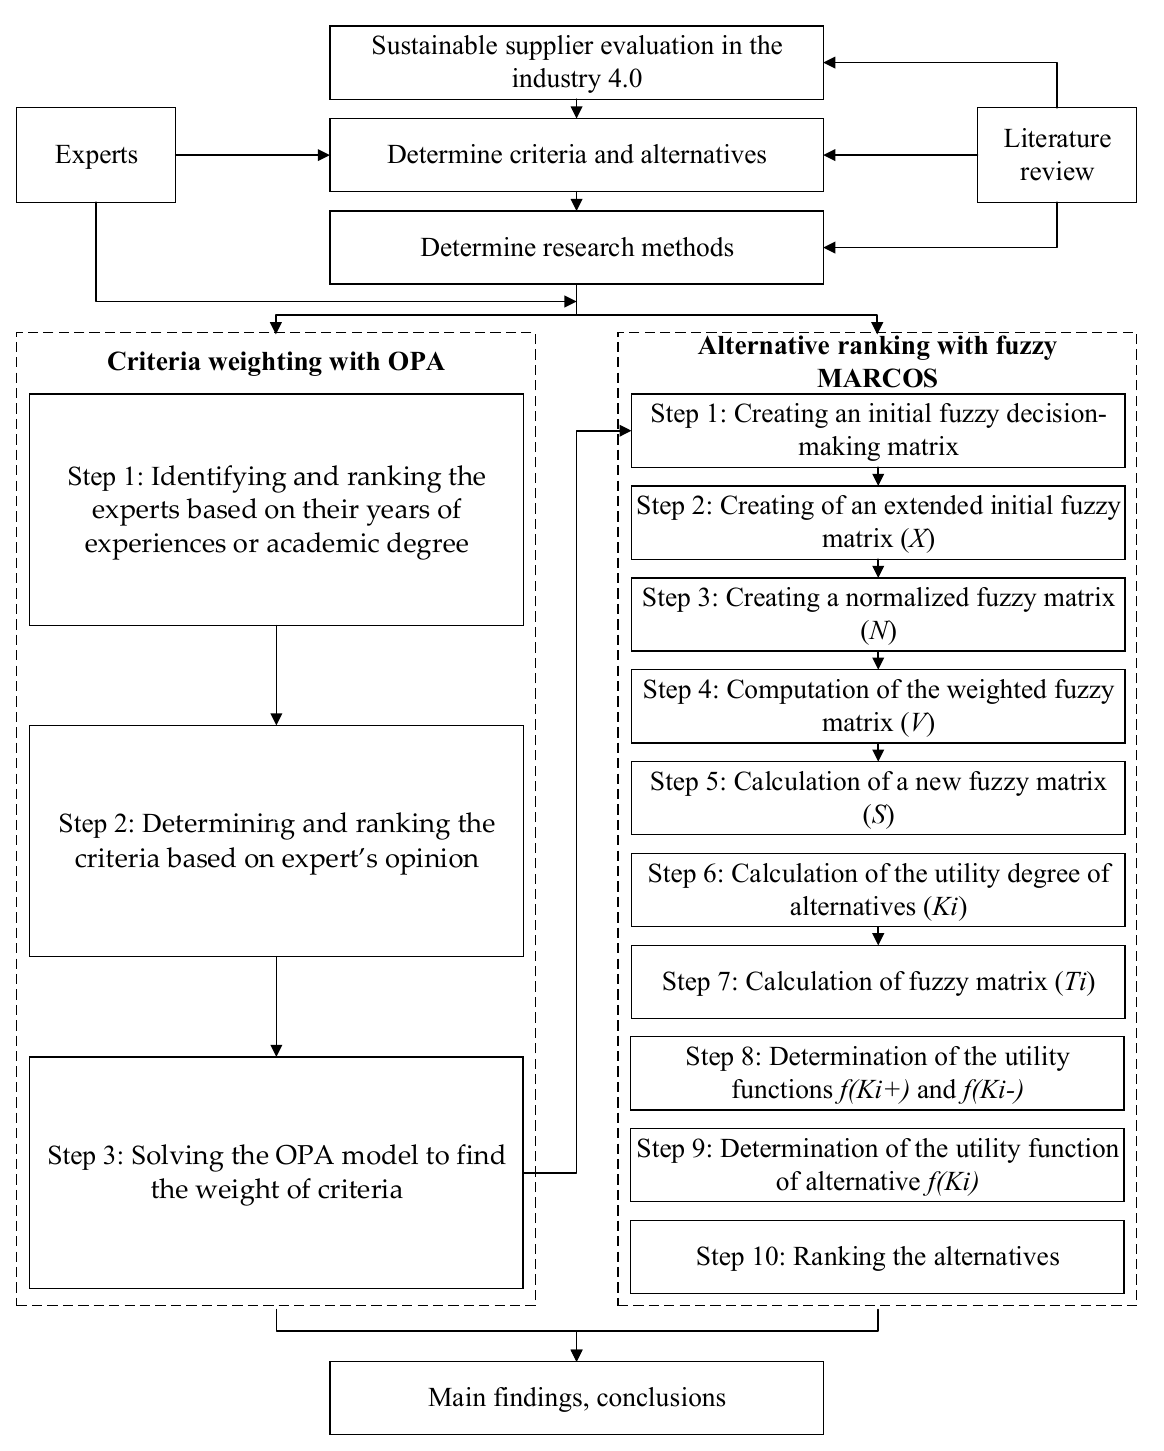
Figure 1. Flowchart of the research.